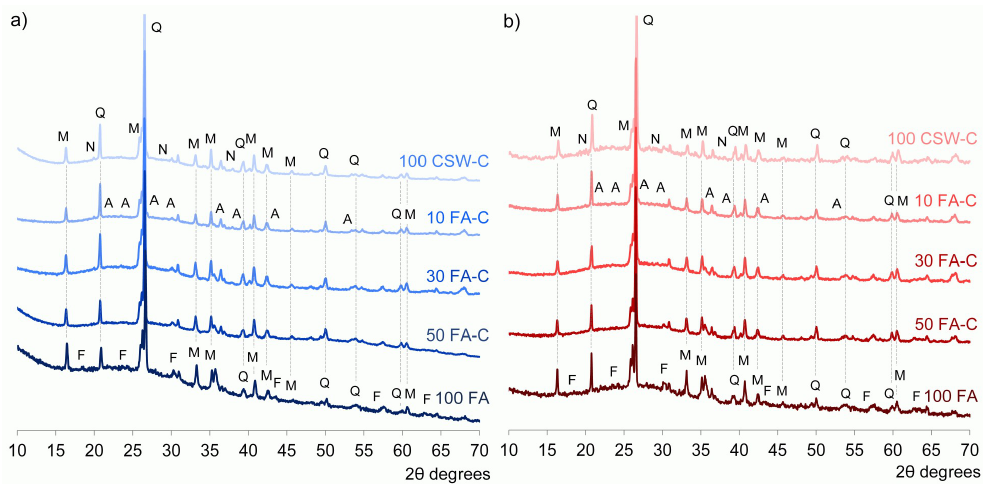
Figure 8. The XRD spectra for the CSW/FA blended pastes that contained 4 wt % Ca(OH) 2 and